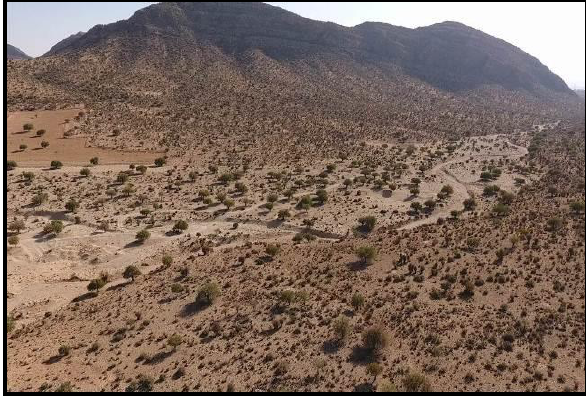
Figure 3. The study site was covered by wild pistachio trees and wild almond shrubs (Photo taken by Phantom-4 UAV).